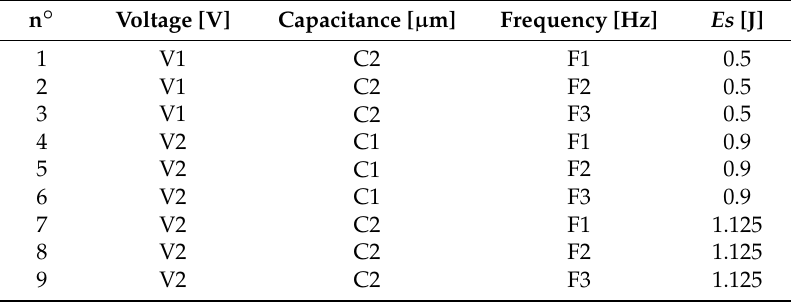
Table 2. ESD process parameters for the